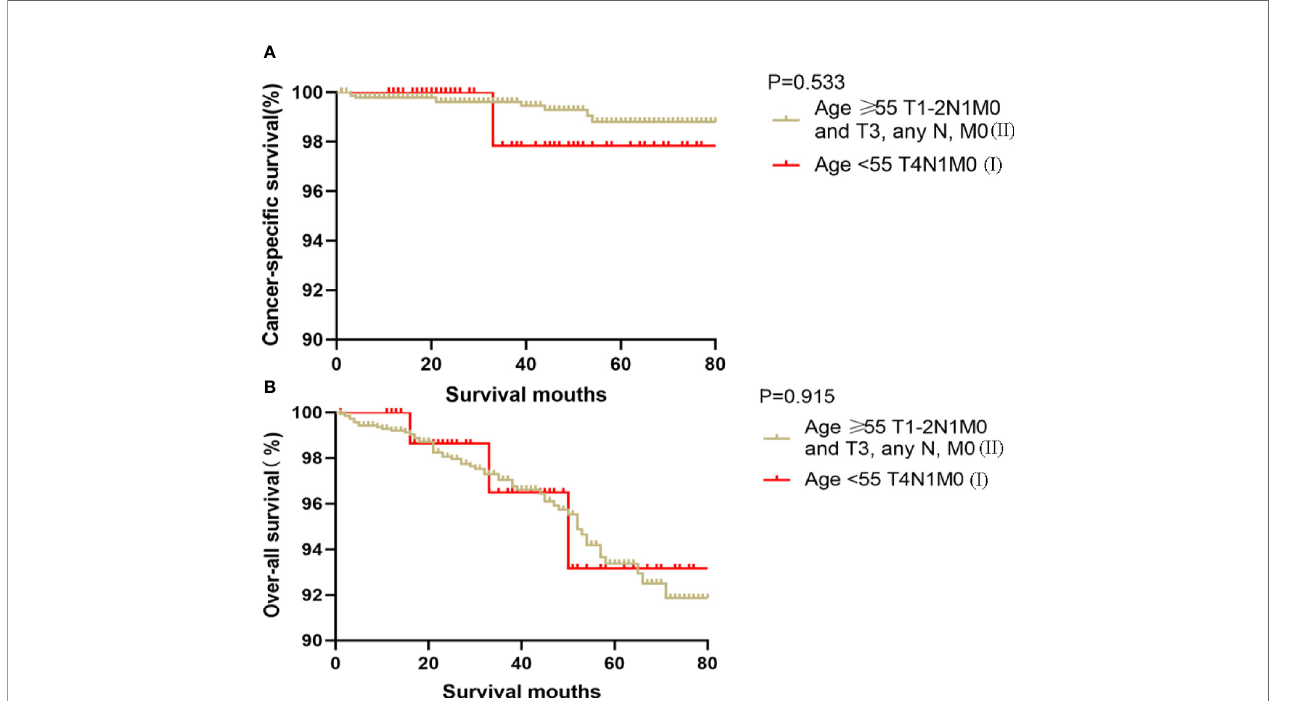
FIGURE 5 | Kaplan – Meier curves for cancer-speci fi c survival (A) and overall survival (B) between FVPTC patients aged ≥ 55 years with stage T1-2N1M0 or T3, any N, M0 disease and patients aged <55 years with stage T4N1M0